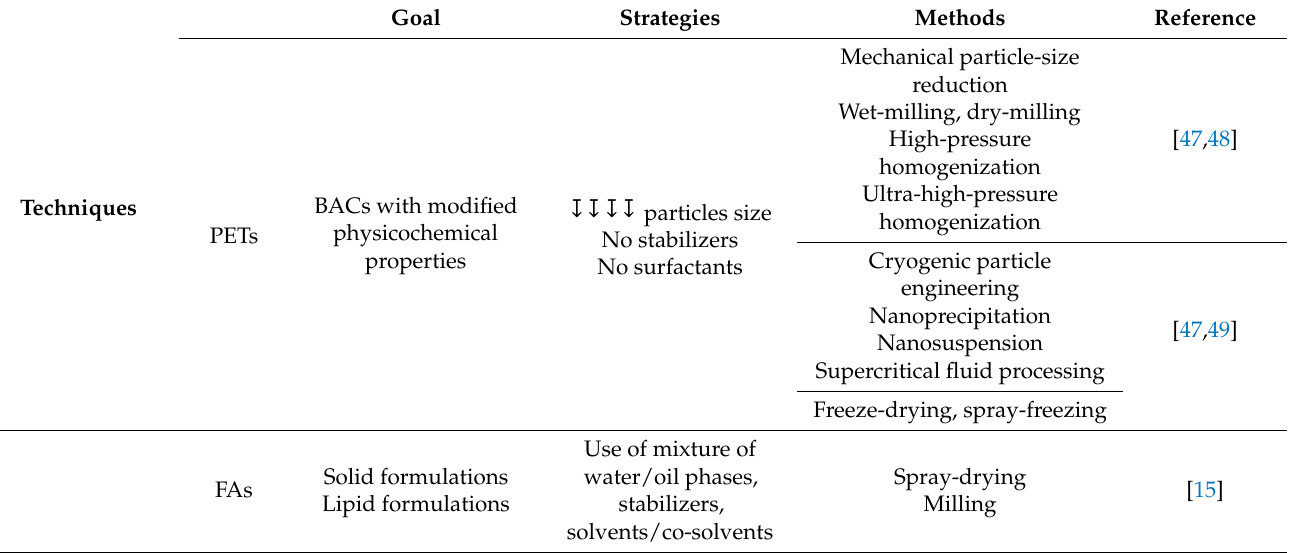
Table 3. Techniques and approaches for enhancing the solubility of BACs.